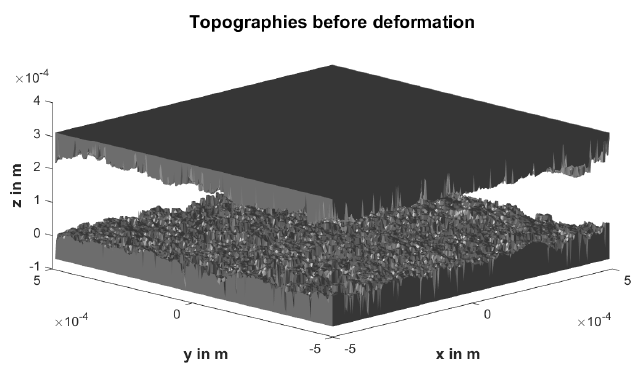
Figure 8. Upwards-facing topographies at start of simulation.